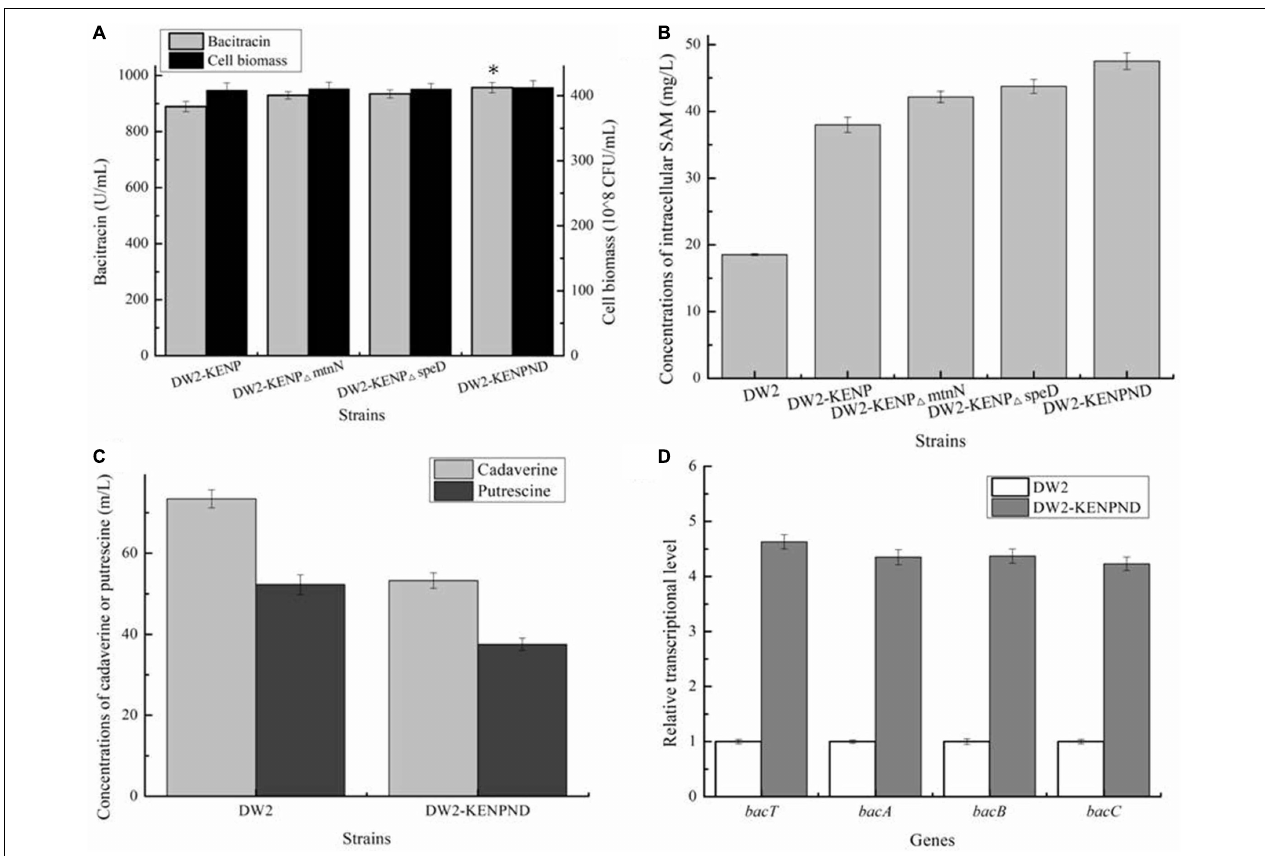
FIGURE 6 | Effects of mtnN and speD deletion on bacitraicn production. (A) Bacitracin yield and cell biomass, (B) The concentration of intracellular SAM, (C) The concentrations of cadaverine and putrescine, (D) Transcriptional level analysis. ∗ P < 0.05 and ∗∗ P < 0.01 indicate the significance levels between recombinant strains and control